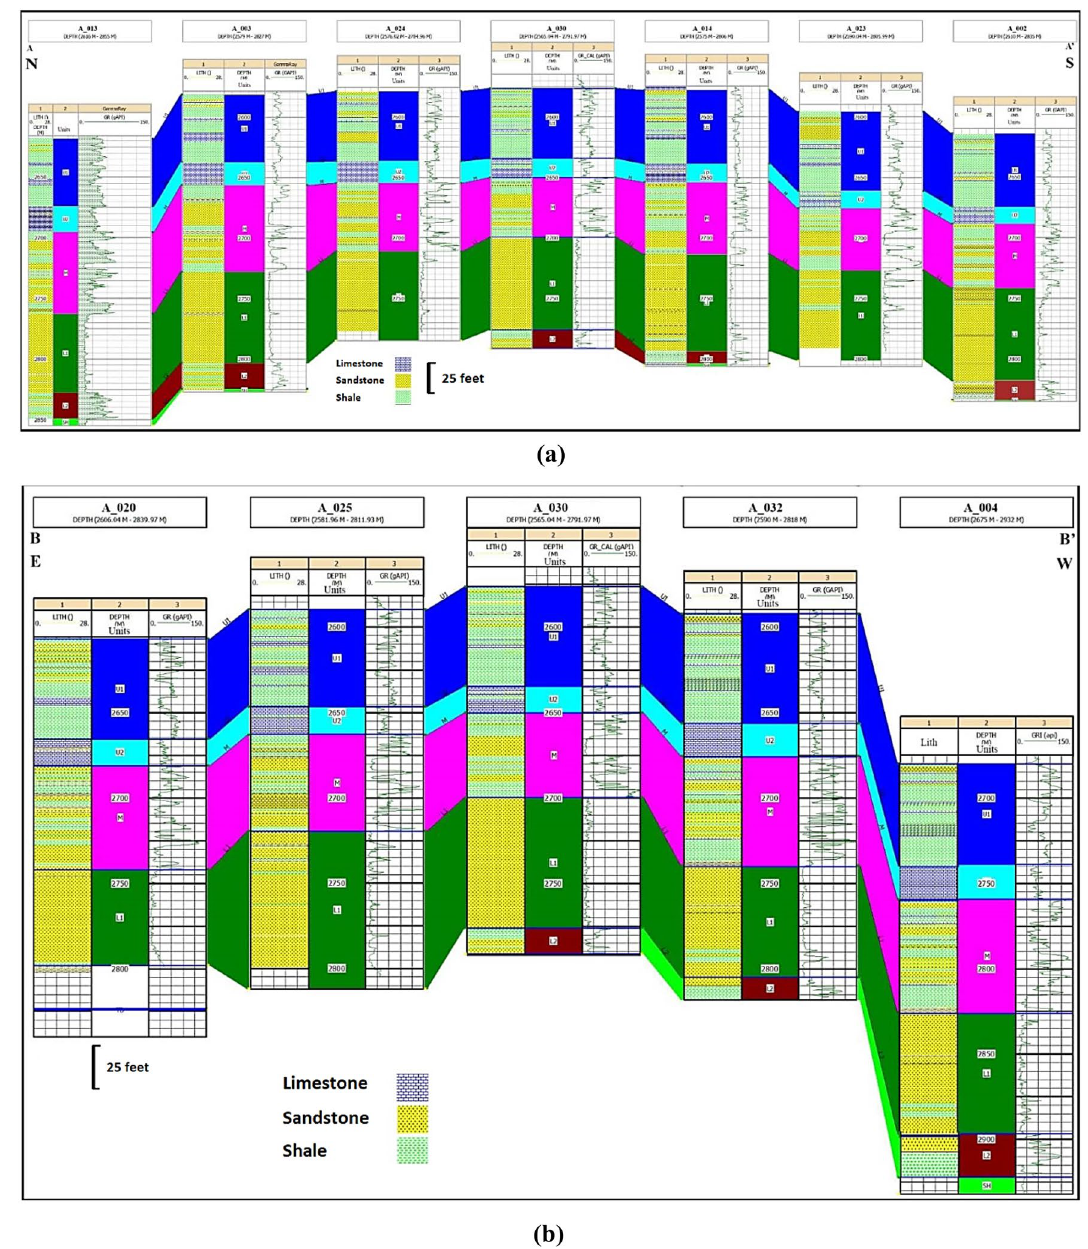
Fig. 13 Lateral variation of the Albian reservoir units in SWM Oil Field along a A–A' profile trending N–S, and b B–B' profile trending NE–SW direction. Profiles' directions are illustrated in Fig.